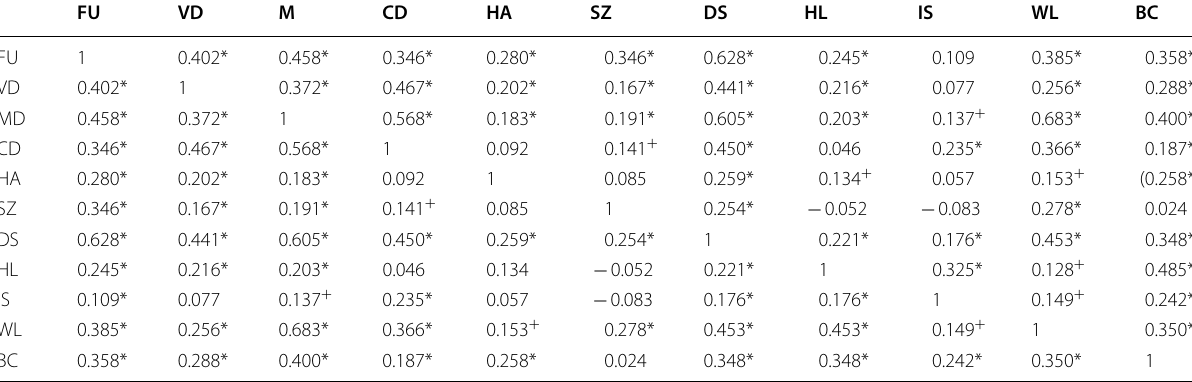
FU, future uncertainty; VD, visual disorder; M, motor dysfunction; CD, communication deficit; HA, headache; SZ, seizures; DS, drowsiness; HL, hair loss; IS, itchy skin; WL, weakness in leg; BC, bladder control + Significant at p <